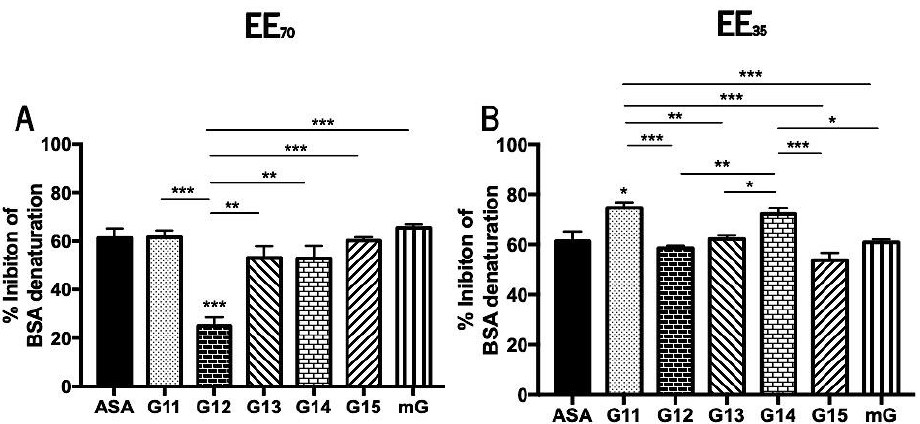
Figure 5. Capacity of G.EEs 70 (A) and G.EEs 35 (B) to inhibit heat-induced BSA denaturation. Data presented as mean ± SEM (*0.05 > p ≥ 0.01, ** 0.01 > p ≥ 0.001, *** p < 0.001). (G: Gerês; mG: a mixture of propolis samples from Gerês; ASA: acetylsalicylic acid).